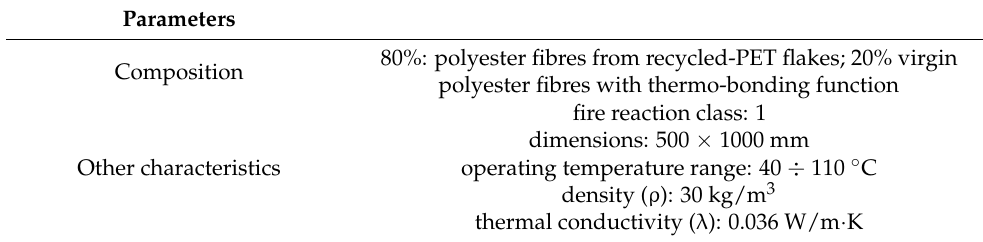
Table 3. Features of the R-PET panel used as an insulation layer in wall 2. Personal elaboration from Ingrao et al. [39].